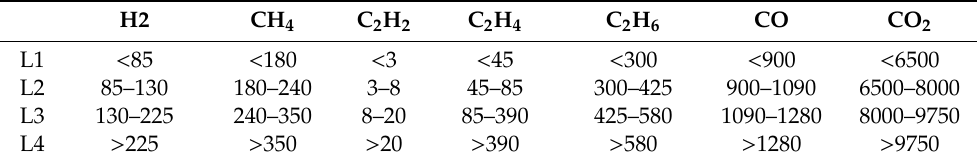
Table 5. Gas concentration, four-levels classification.